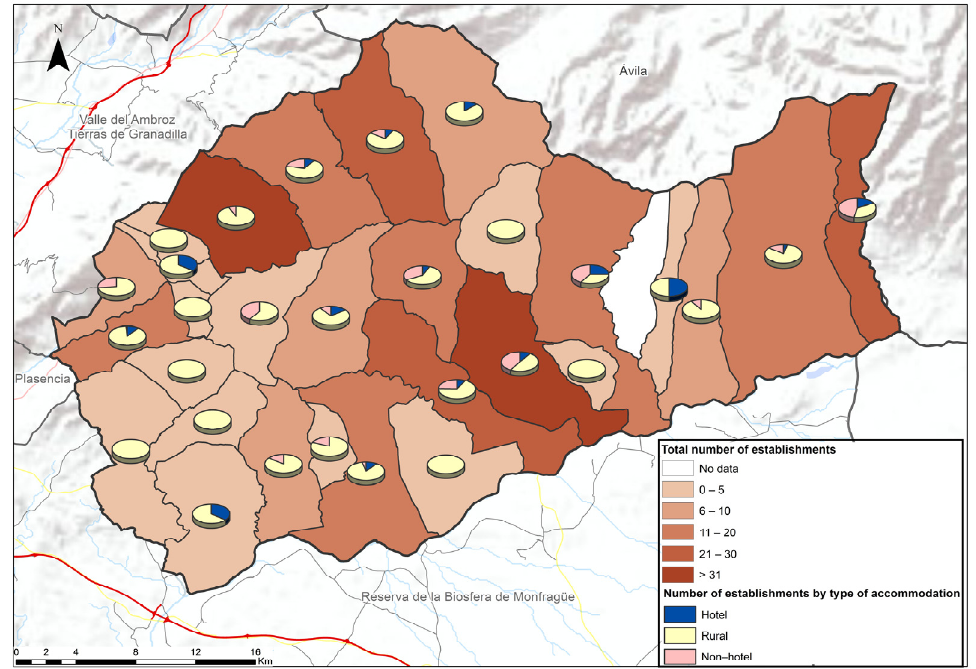
Figure 10. Map of the number of accommodations and their typologies by municipality.